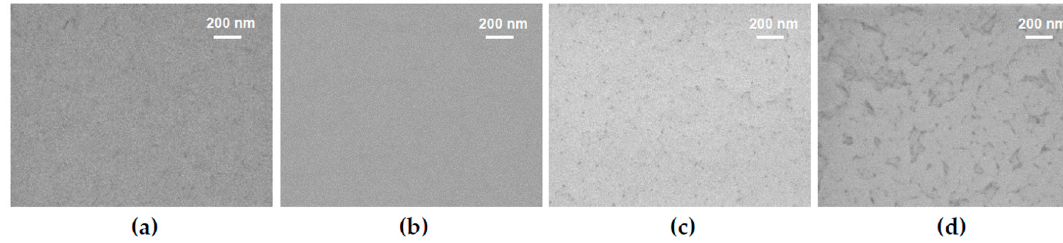
Figure 1. SEM surface images of: ( a ) 25 nm thickness film; ( b ) 35 nm thickness film; ( c ) 50 nm thickness film; ( d ) 70 nm thickness film.